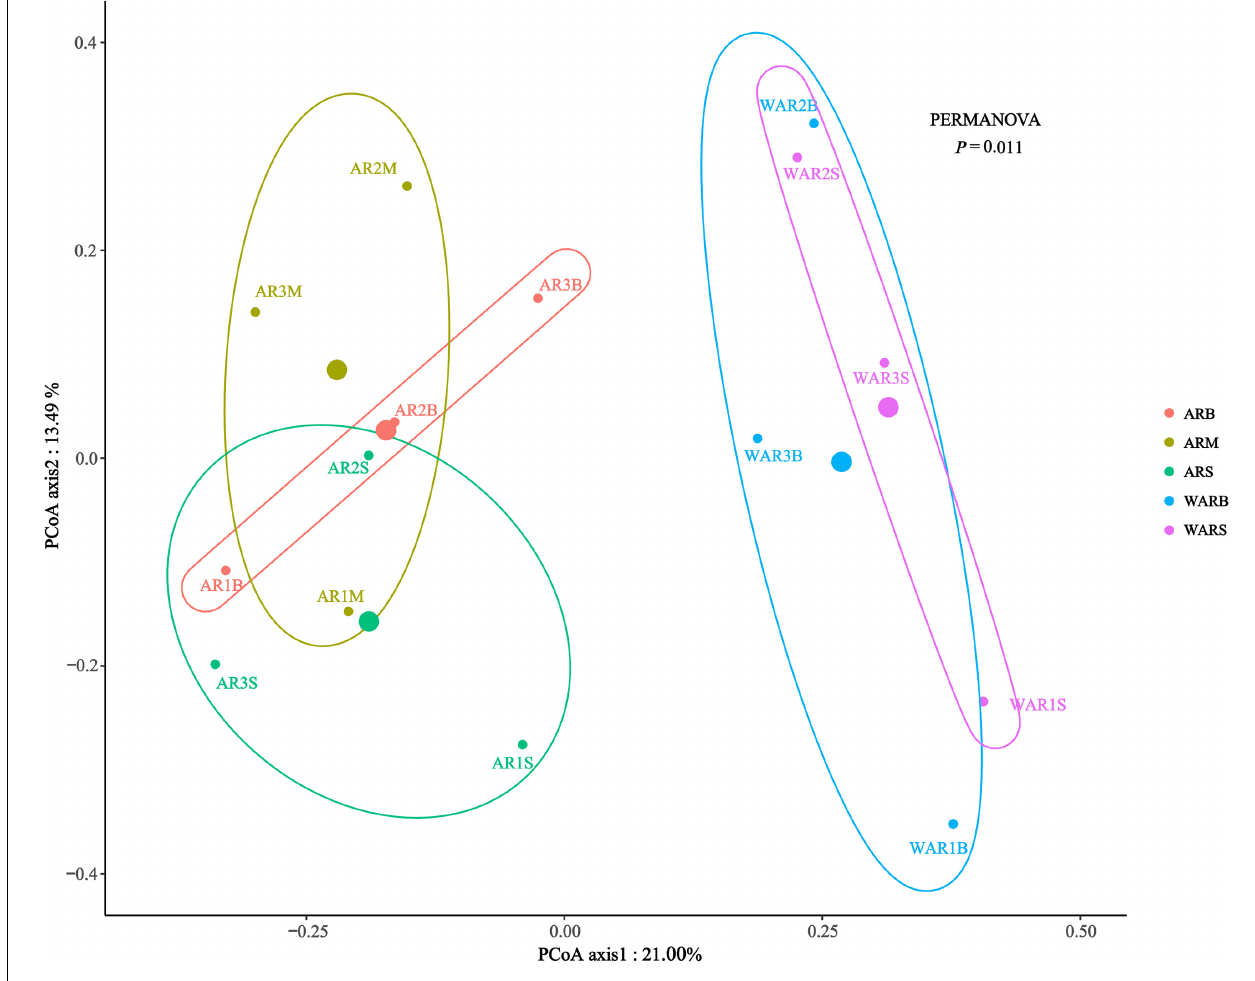
FIGURE 4 | β -Diversity evaluated based on Bray–Curtis dissimilarities in all samples. PCoA plot of the Bray–Curtis distances. The largest point is the centroid of each